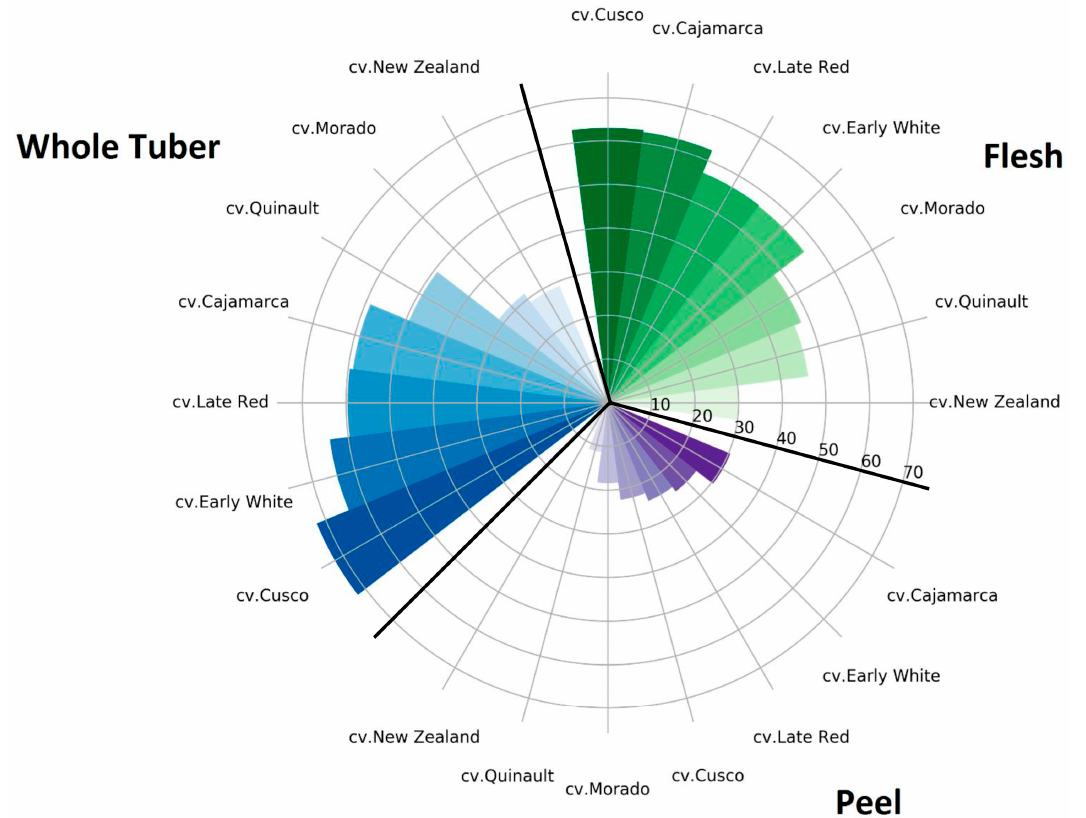
Figure 2. Classification of different parts (flesh, peel, and whole tuber) of the yacon tuber according to total sugar (fructose + glucose + sucrose) content (g 100 g − 1 DW).